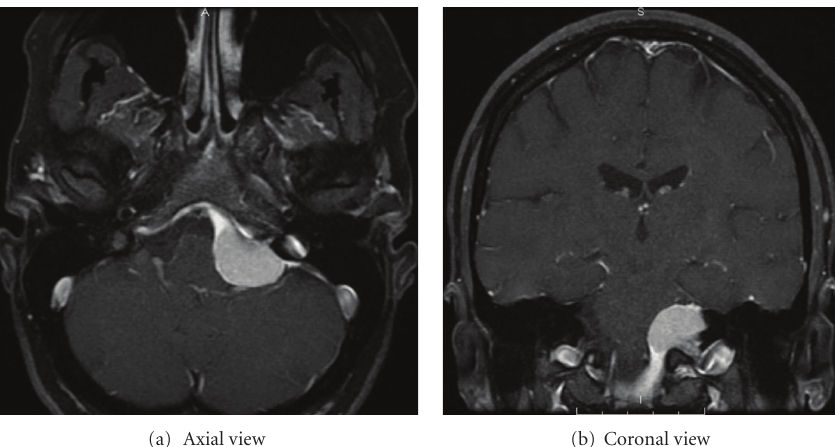
Figure 1: Preoperative axial and coronal MRI images of the patient’s brain. Gadolinium enhancement demonstrates a large mass in the left cerebello-pontine angle.